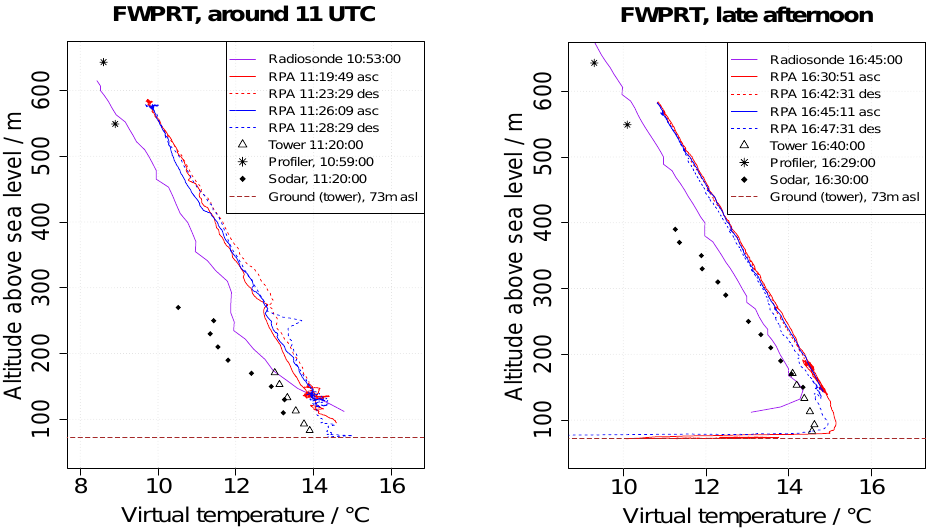
Fig. 10. Comparison of FWPRT on the RPA with remote sensing and tower data for vertical profile flights on Sunday, 23 September 2012.